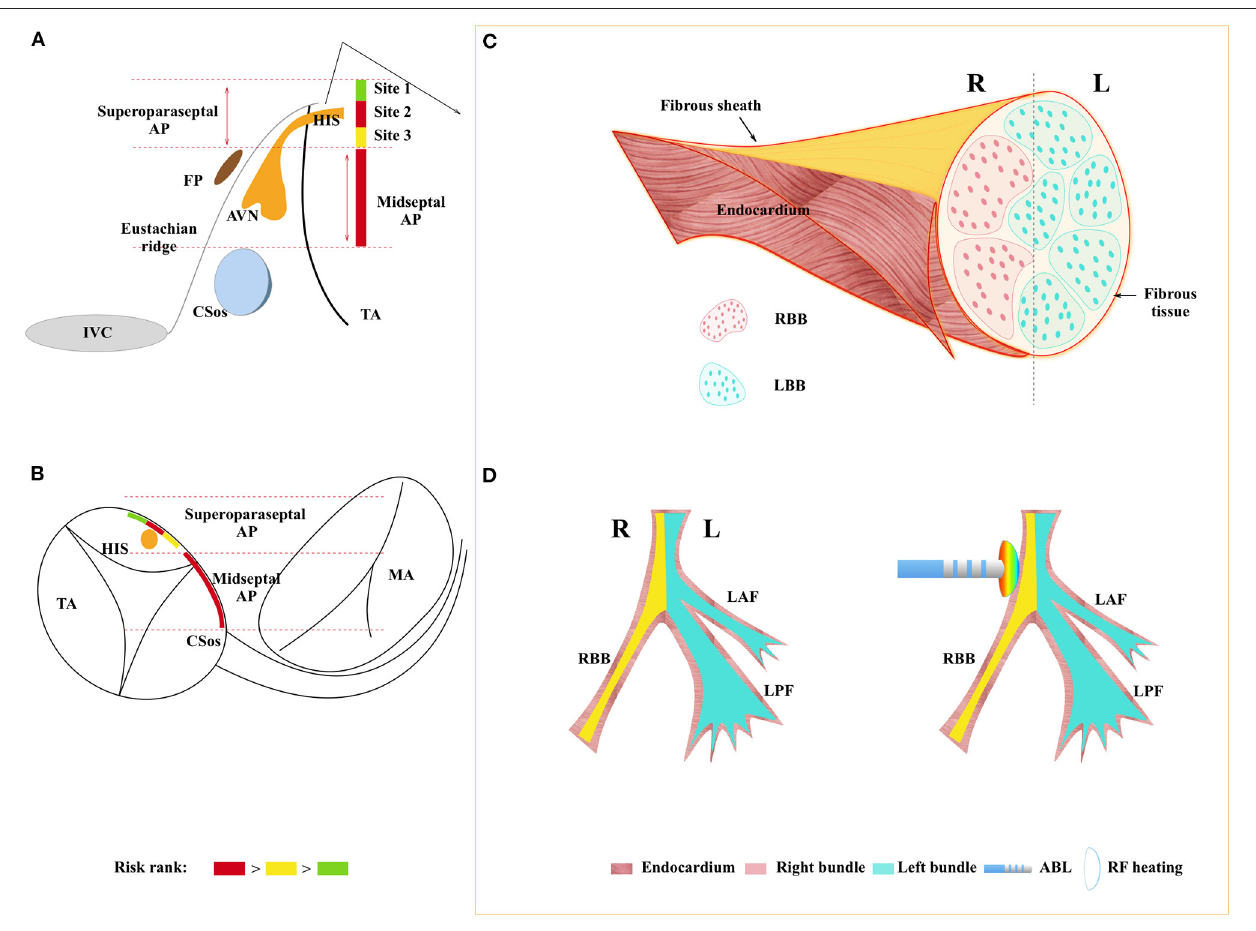
FIGURE 4 | (A) : Schematic representation of the septal region. (A) : right anterior oblique (RAO) view. (B) : left anterior oblique (LAO) view. The septal region usually is bounded superiorly by the His bundle (HBE) and inferiorly by the roof of the coronary sinus (CS). Dividing this area into three parts, para-Hisian accessory pathways occupy the superior third of the area and midseptal APs occupy the middle third. Site 2 and midseptal are the most risky sites, following with site 3 and site 1. (C) : His-Purkinje anatomy with longitudinal dissociation and it was surrounded by a fibrous sheath, right bundle branch, and the left bundle branch close to each side of the endocardium. (D) : left panel shows the overall view of the His-Purkinje system; the right panel shows the RF delivered at the para-hisian region, heat could transfer from the endocardium to the right bundle inside which could cause RBBB as consequence. AVN, AV node; IVC, inferior vena cava; TA, tricuspid annulus; MA, mitral annulus; HIS, His bundle; AP, accessory pathway; FP, fast pathway; RBB, right bundle branch; LBB, left bundle branch; LAF, left anterior fascicle; LPF, left posterior fascicle; ABL, ablation catheter; Endo,